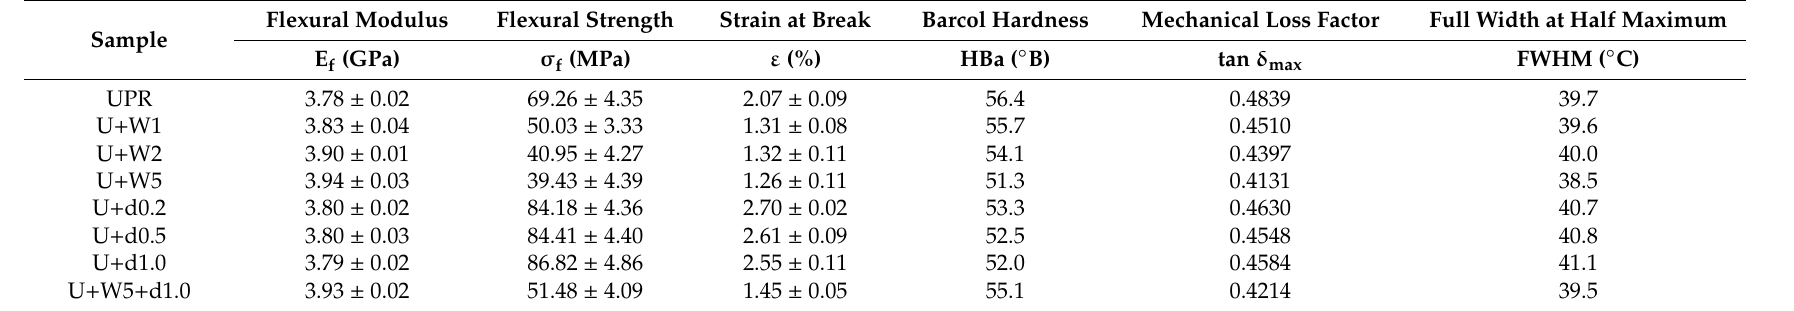
Table 3. Mechanical and thermomechanical data of the samples after the accelerated aging